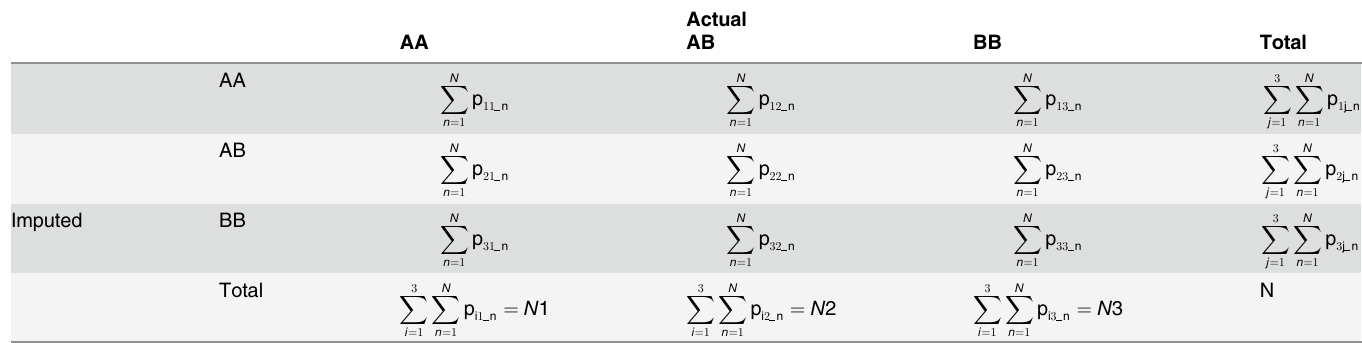
Table 1. Calculating concordance (P 0 ) and IQS from imputed genotype probabilities and actual genotypes. The table was created by summing over probabilities for all N individuals (n = 1 to N) in each cell with p ij_n representing the probability that the nth individual has the imputed genotype i and actual genotype j, where 1 corresponds to AA, 2 corresponds to AB, and 3 corresponds to BB. N 1 = number of individuals with AA actual genotype, N 2 = number of individuals with AB actual genotype, N 3 = number of individuals with BB actual genotype, and N = number of total